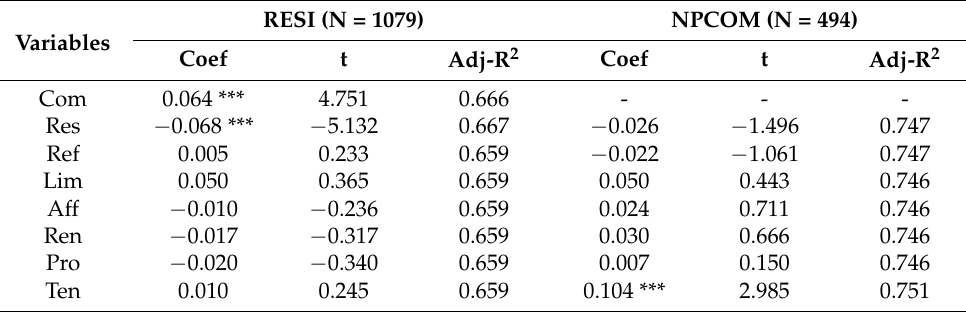
Table 3. Linear regression results of the residence